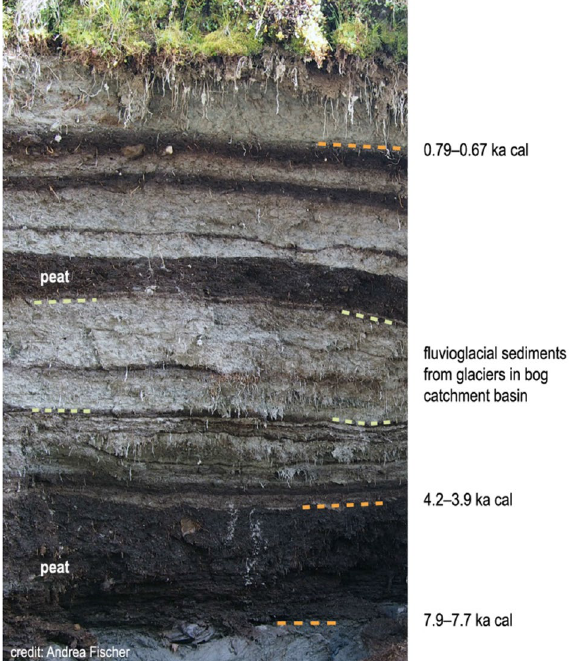
Figure 3. Photograph of the Buntes Moor bog profile with indicated radiocarbon ages 28 as orange dashed lines. Buntes Moor is located contiguous to the LIA terminus of Fernauferner glacier. Grey layers are fluvioglacial sediments from the basin (e.g. yellow dashed lines). Dark layers are peat formed during warm periods. Figure made with licensed software Adobe Illustrator CS6 (https ://www.adobe